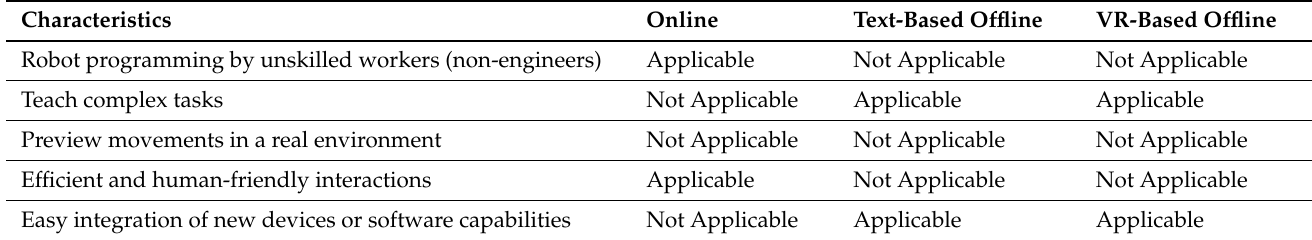
Table 1. A comparison of different programming